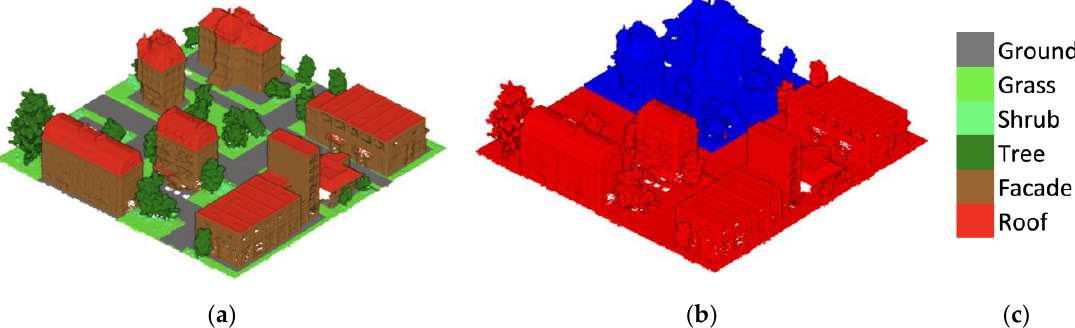
Figure 12. 3DOMCity point cloud and its six classes ( a ). The dataset is separated ( b ) into training (~70%, blue) and test (~30%, red). ( c ) Legend.